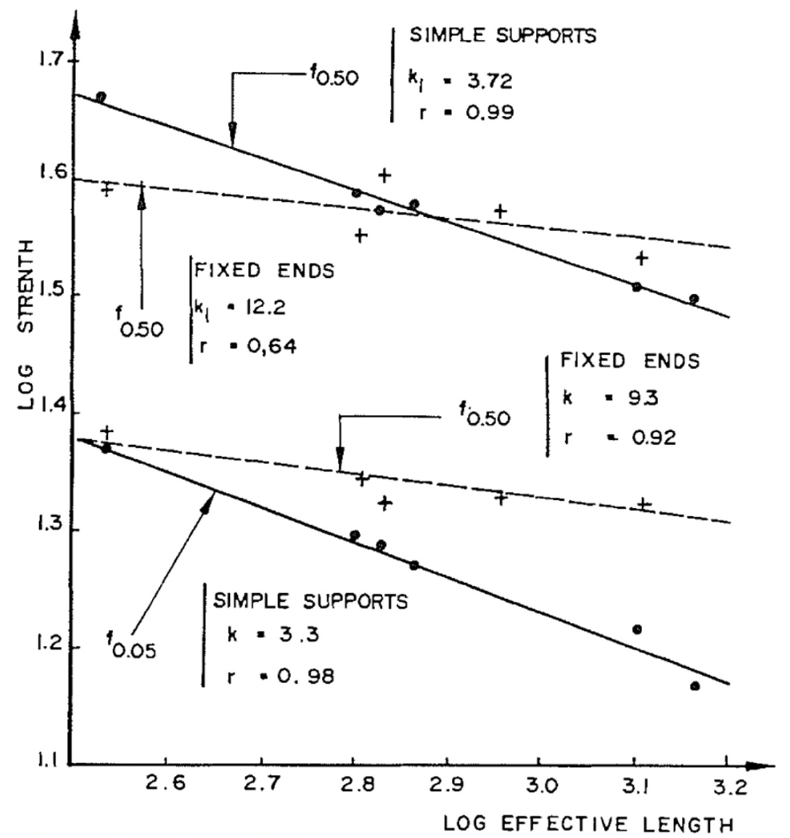
Figure 42. Plot showing the effect of length on the strength of wooden beams. From [86].